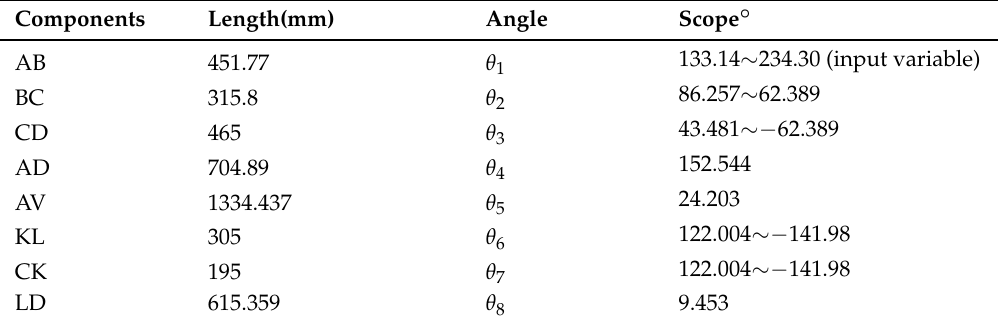
Figure 4. The main connecting and lock mechanism. Table 3. Slider-crank